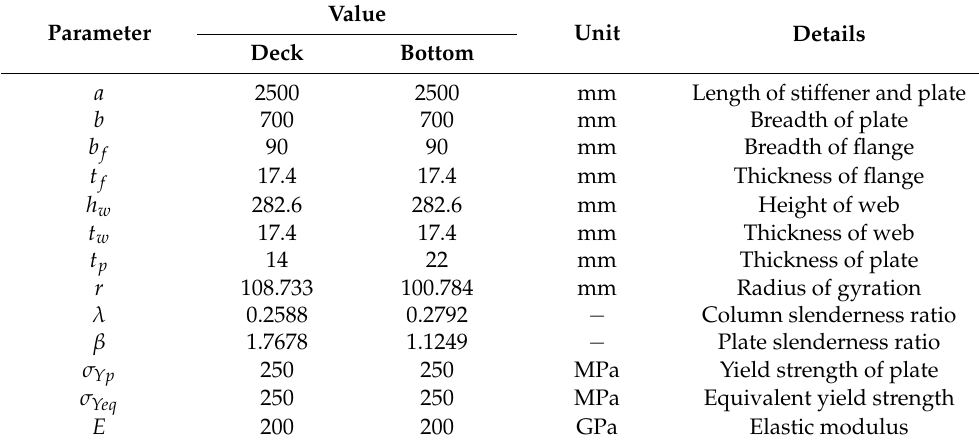
Table 7. Parameters of stiffened panel with angle-bar stiffener at deck and bottom and related properties of barge.